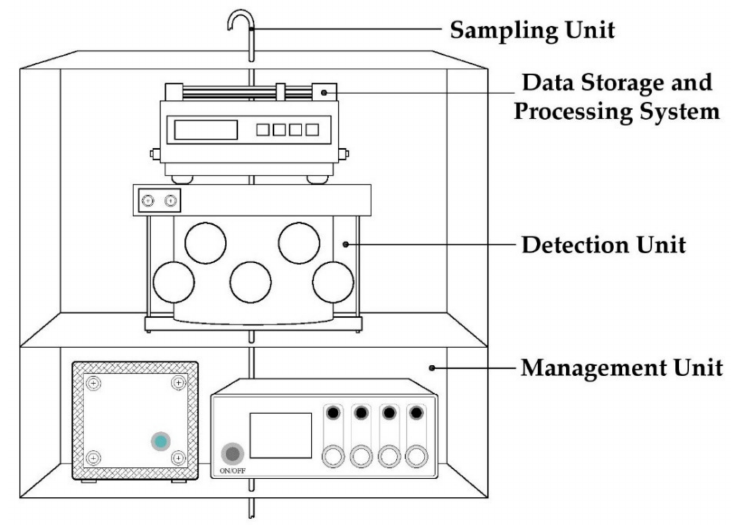
Figure 1. Main functional units of the used Instrumental Odour Monitoring System (IOMS).